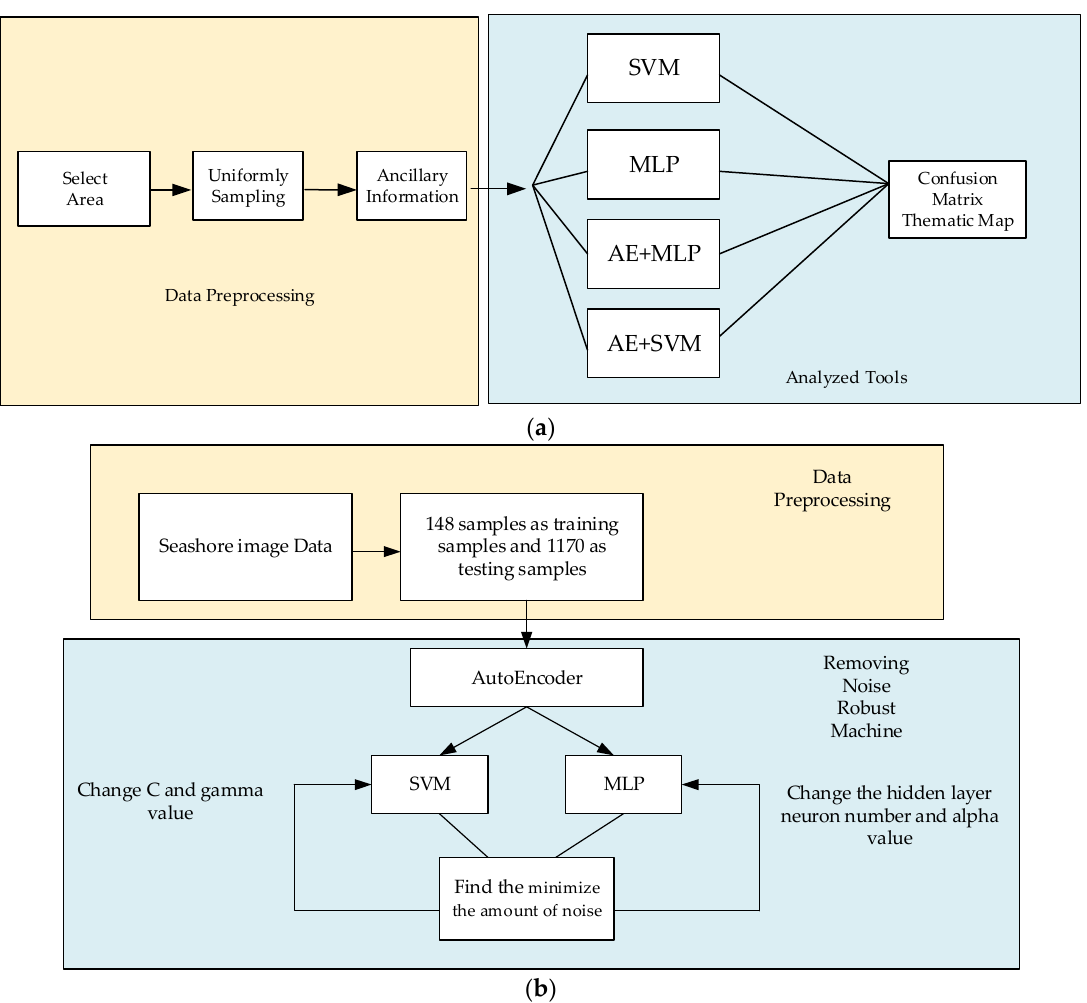
Figure 4. ( a ) Research steps; ( b ) Development of Robust Machine to remove image classification